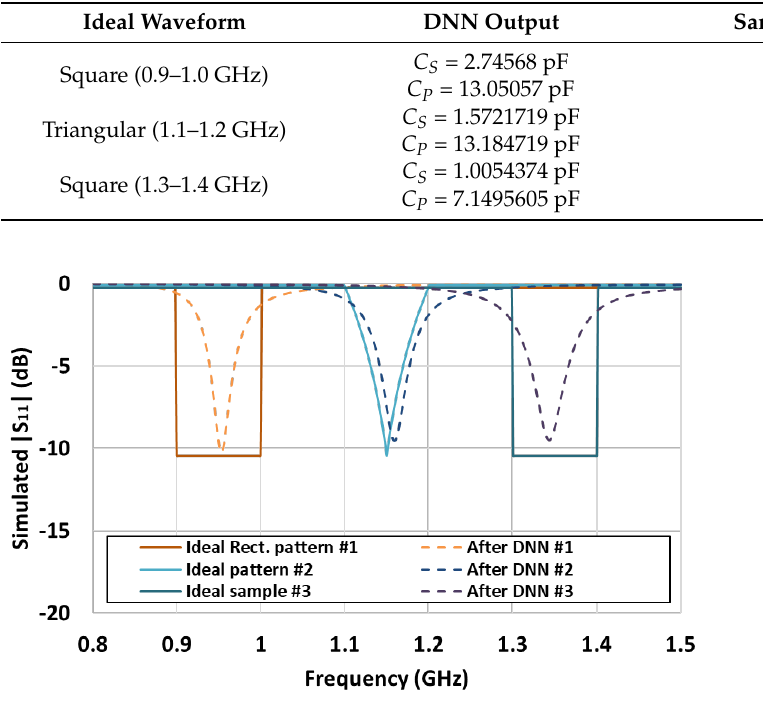
Figure 8. Comparison of ideal S 11 waveform with that obtained from DNN results.